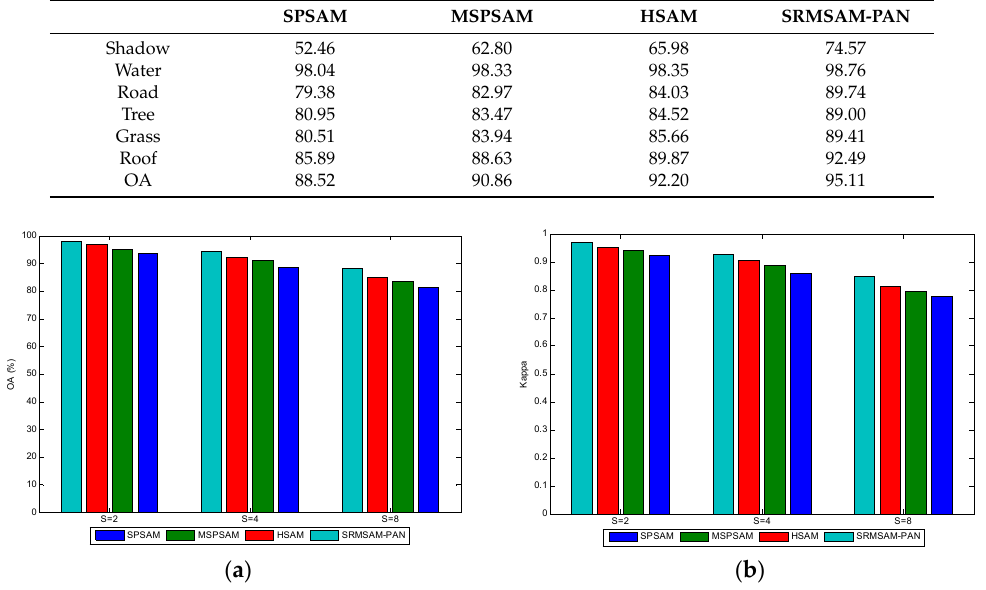
Table 2. Mapping accuracy (%) of the four methods ( S = 4).